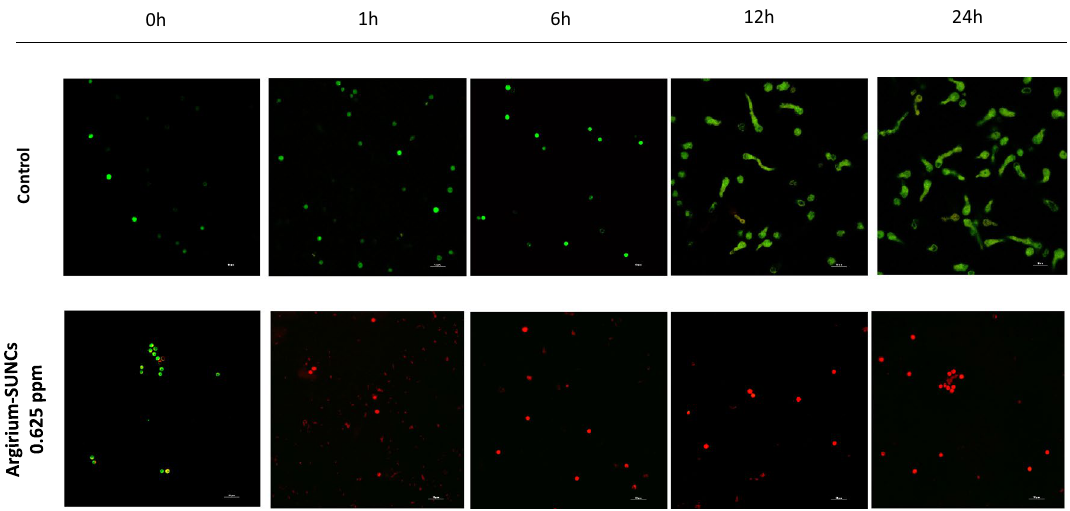
Figure 2. Effect of sublethal concentration (0.625 ppm) of Argirium-SUNCs on A. niger GM31 cell viability. Live and death as (green) intact fungal structure; (red) damaged fungal structure were visualized by fluorescence microscopy after staining with CFDA (carboxyfluorescein diacetate) and PI (propidium iodide). Scale bar 20